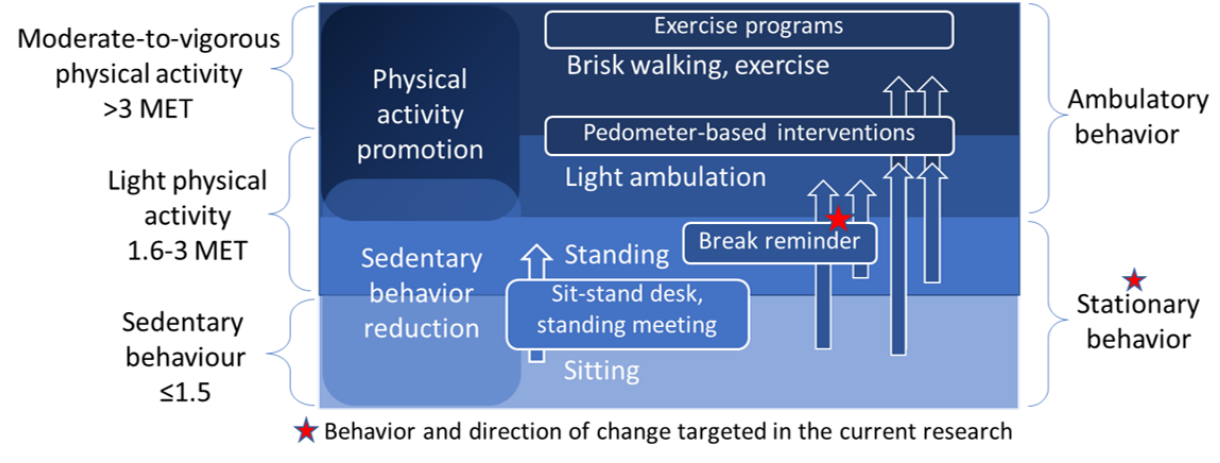
Figure 2. The intervention continuum from sedentary behavior reduction to physical activity